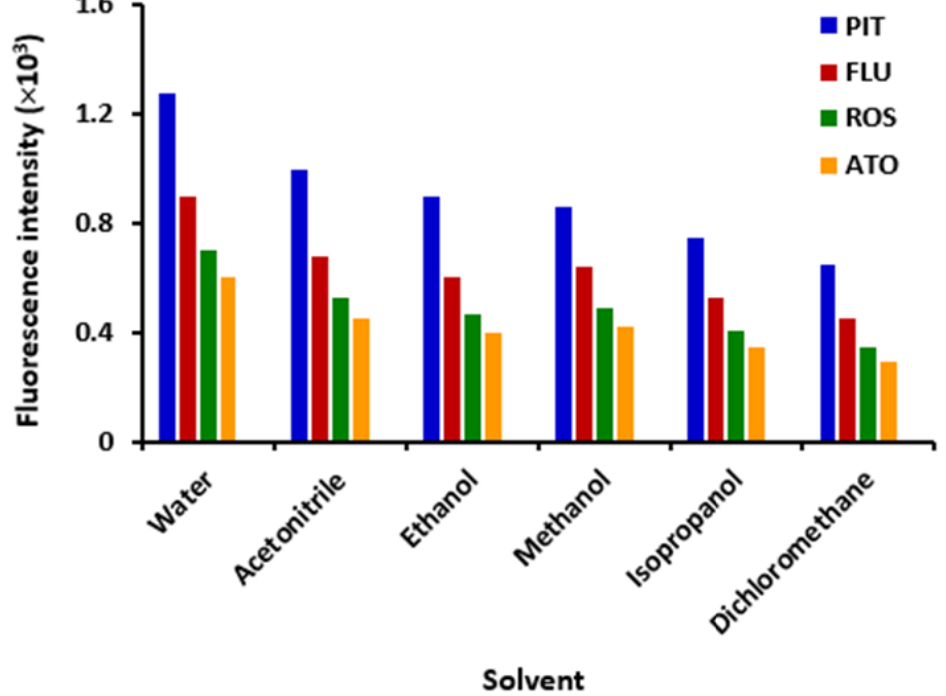
Figure 3. Effect of solvent on the fluorescence intensity of statin solution (in water). Concentrations were 1, 2, 5 and 50 µg mL –1 for PIT, FLU, ROS and ATO, respectively. Values are the mean of 3 determinations.